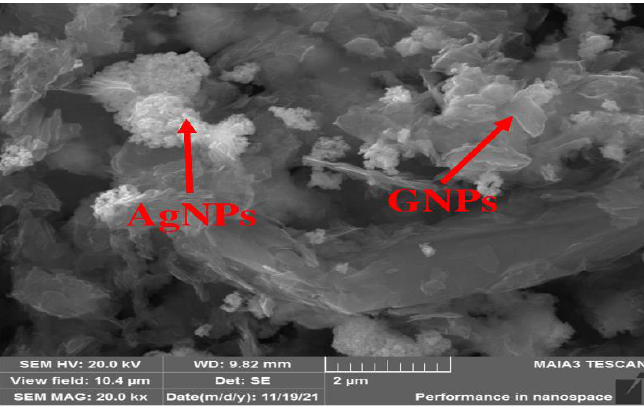
Figure 6. Morphology of 50% GNPs-Ag nanocomposites.